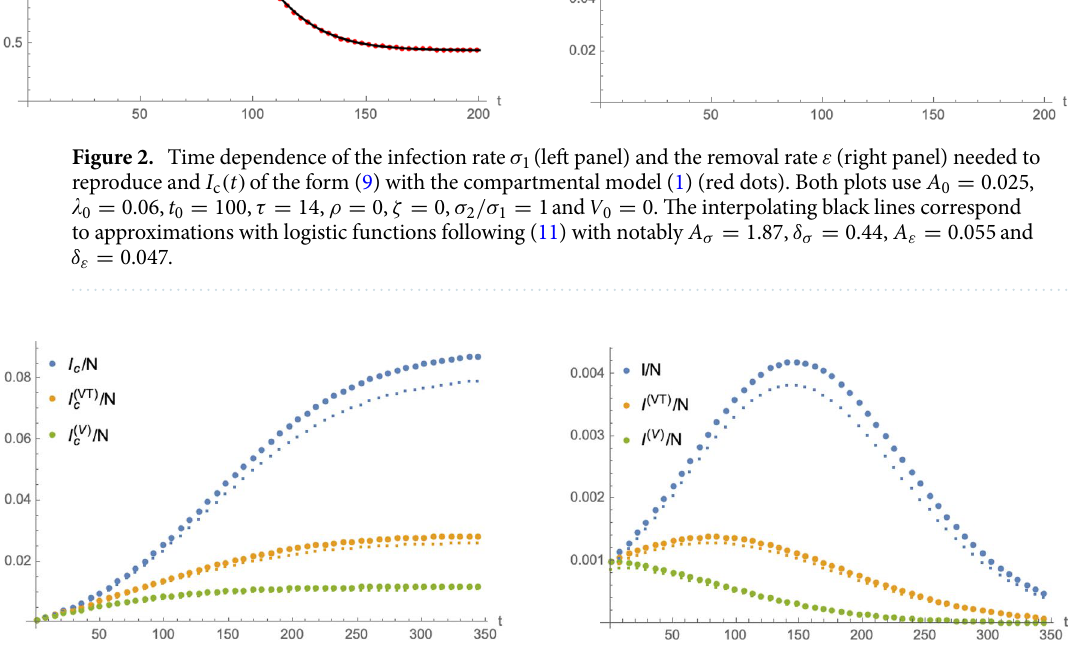
Figure 3. Numerical solutions of the SIIRV model with different variants of a HP: solutions of Eq. (1) are represented by blue points, those of Eq. (4) by orange points and those of (6) by green points. The left panel shows the cumulative number of infected individuals (large points stand for the total numbers, while small points represent only the unvaccinated individuals) and the right panel the infectious individuals as functions of time. Both plots use σ 1 = σ 2 = 1.6 , ε = 0.1 , ζ = 0.15 , ρ = 0.0005 and V 0 = 0.3